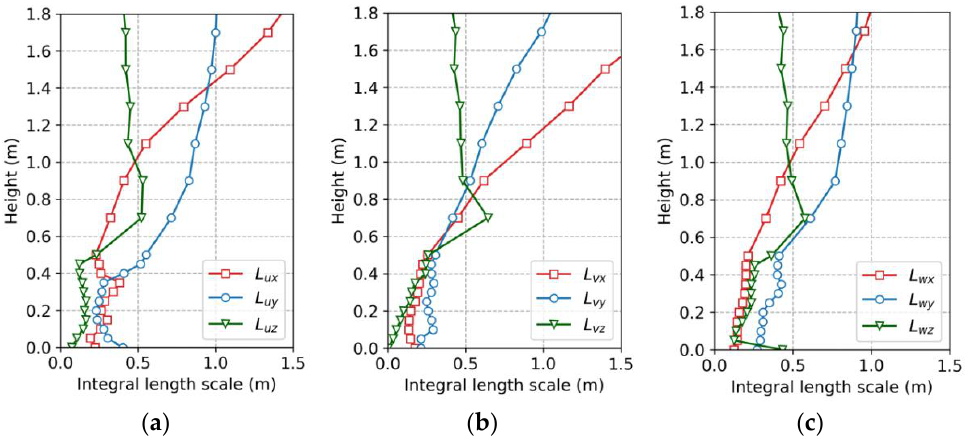
Figure 8. The vertical profiles of the integral length scales of the numerical turbulence field. ( a ) the